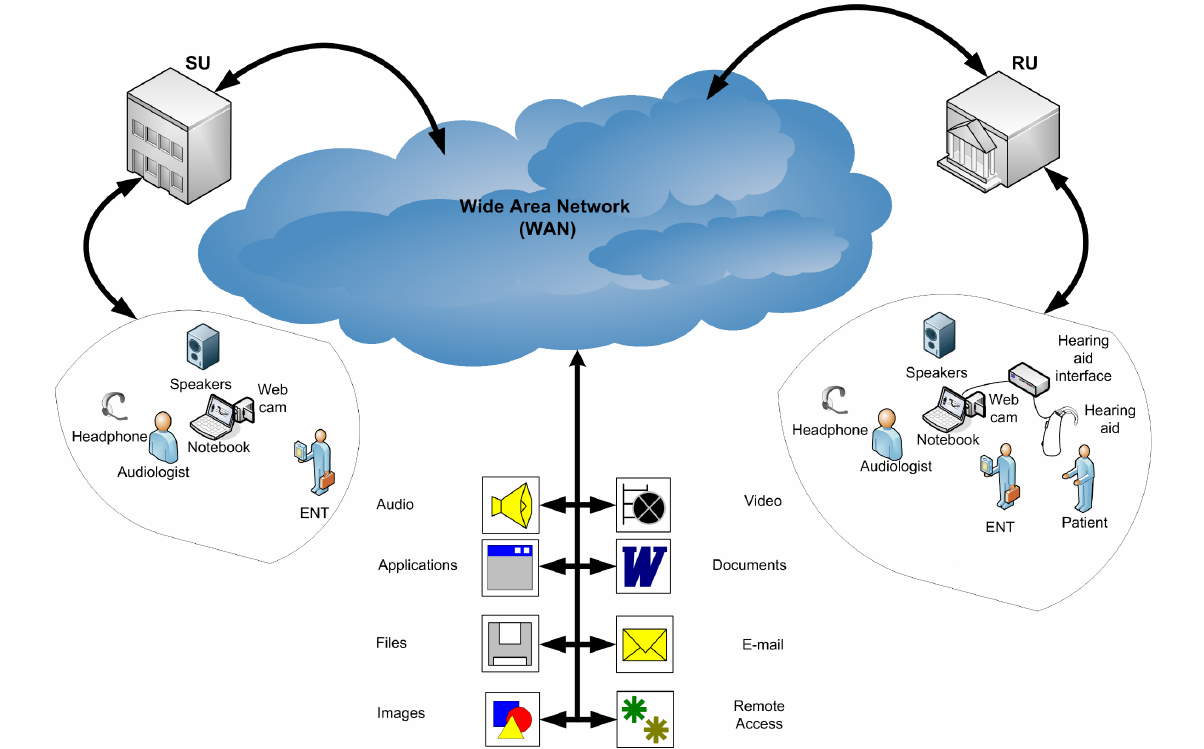
Figure 2. Basic scheme in telefitting session.